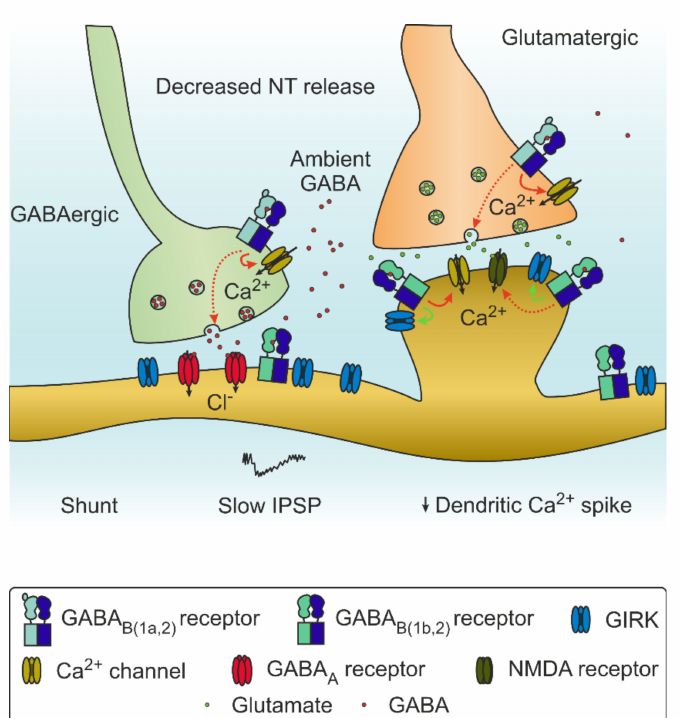
Figure 2. Functions of GABA B Rs in modulation of synaptic transmission. GABA B Rs are expressed pre-synaptically at both GABAergic (left, green) and glutamatergic (right, orange) synapses, where they can inhibit vesicle fusion and neurotransmitter release through inhibition of Ca 2+ channels. They are also present post-synaptically, and they influence GIRK as well as the NMDA receptor function. Activation of GABA B Rs on the post-synaptic side leads to slow GIRK-channel-mediated IPSP and shunting inhibition, which can consequently inhibit dendritic calcium spike propagation. For details, see